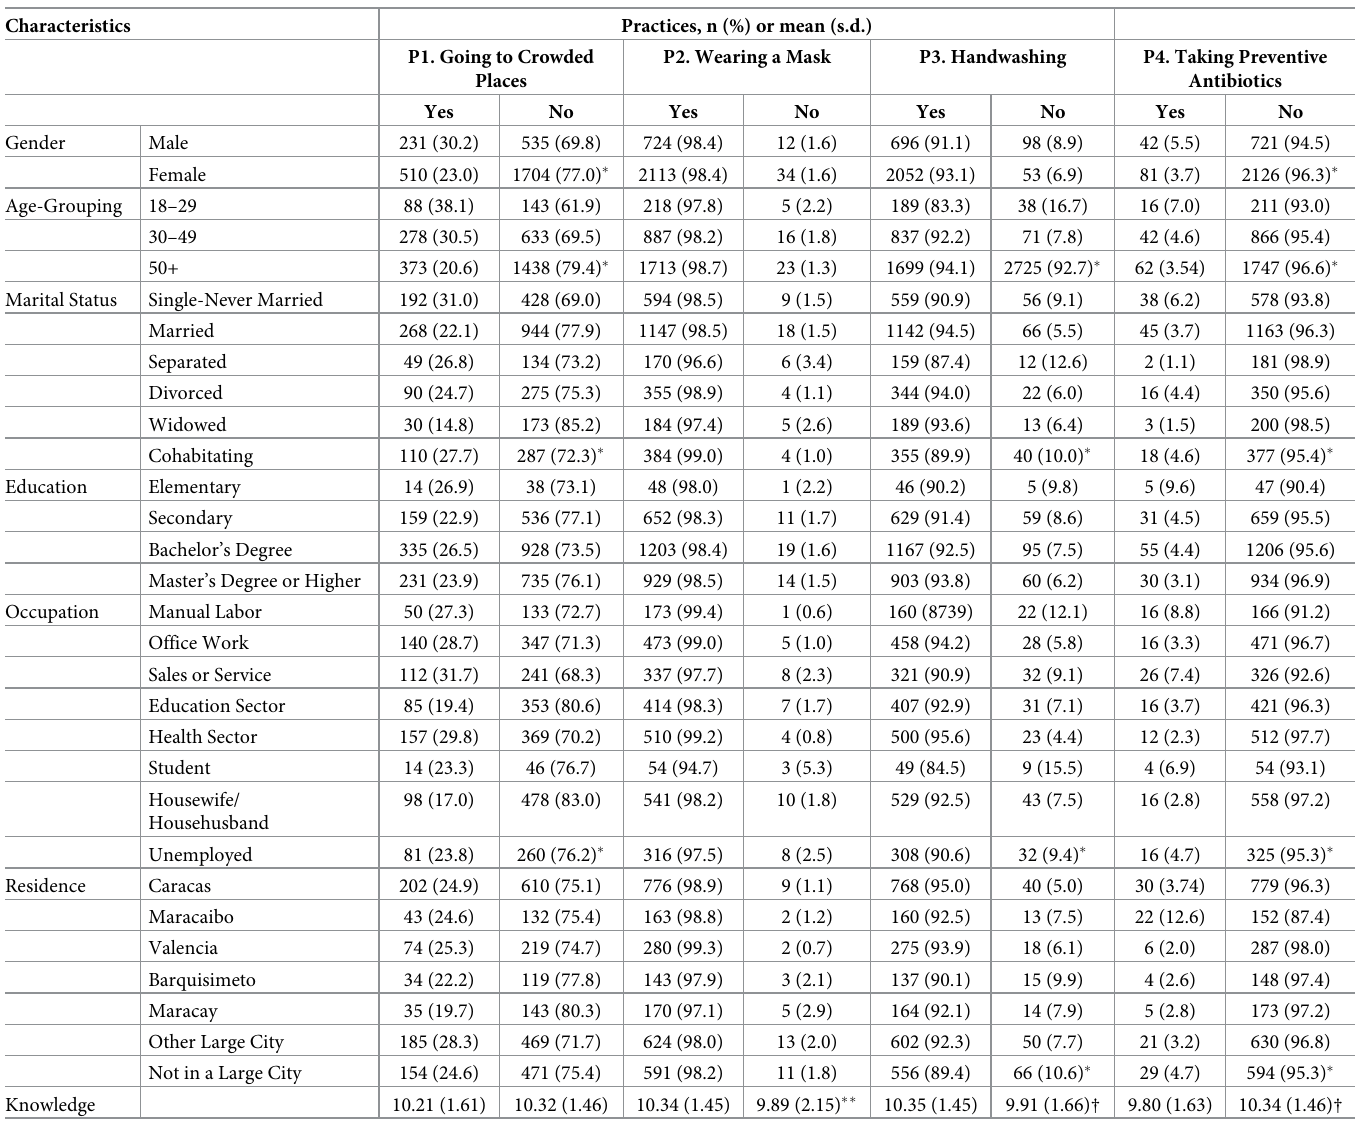
Table 4. COVID-19 Control Practices by demographic